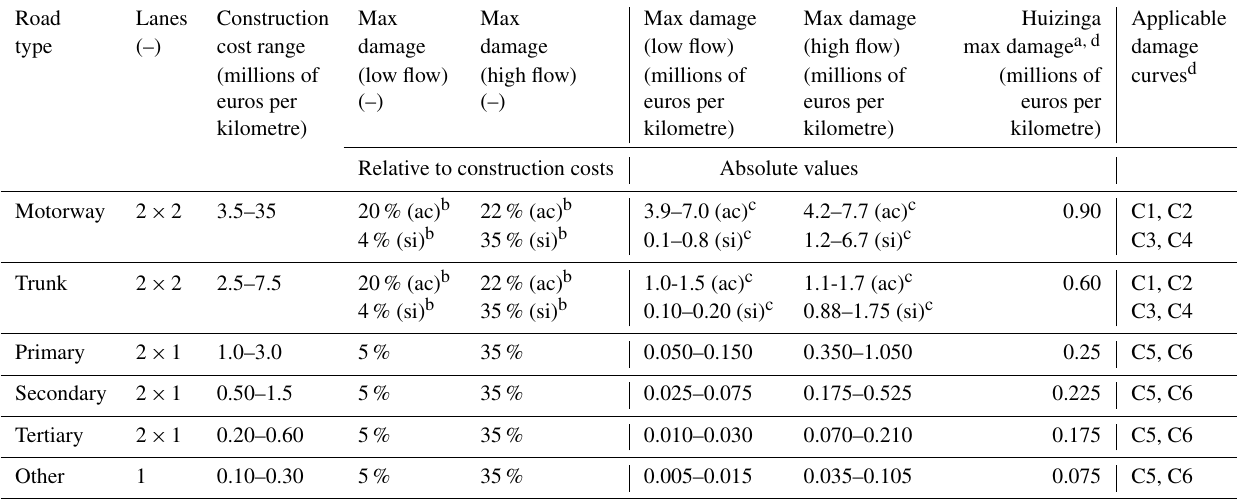
Table 1. Road construction costs and maximum damage per road type, differentiated between low flow (low-flow velocities) and high flow (high-flow velocities). The values present the average for the former EU-28, in millions of euros (year 2015) per kilometre.